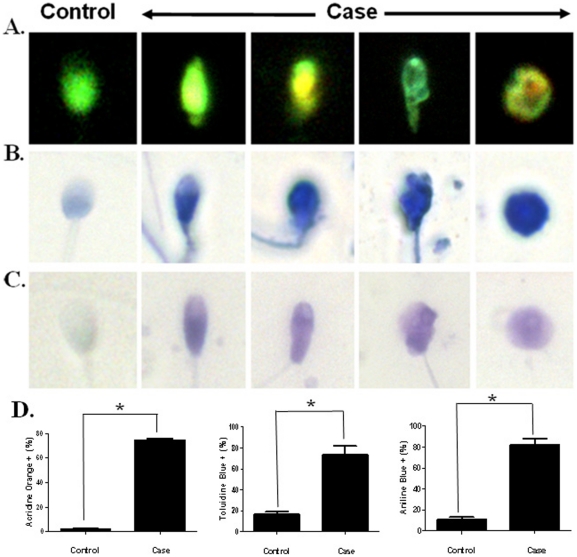
Nuclear DNA damage in the spermatozoa of infertile men who carried c.474A/A.(A.–C.) The spermatozoa were stained with AO (A.), TB (B.) and AB (C.) dyes. (A.) The spermatozoa with normal (green) or abnormal nucleus (yellow). (B.–C.) Spermatozoa with normal (light blue) or abnormal (dark blue) nucleus. (Magnification: ×1,000). (D.) Quantification of the percentage of AO-, AB- or TB- stained spermatozoa. At least 100 spermatozoa cells were counted in each case (*: p<0.05; Mann-Whitney test).